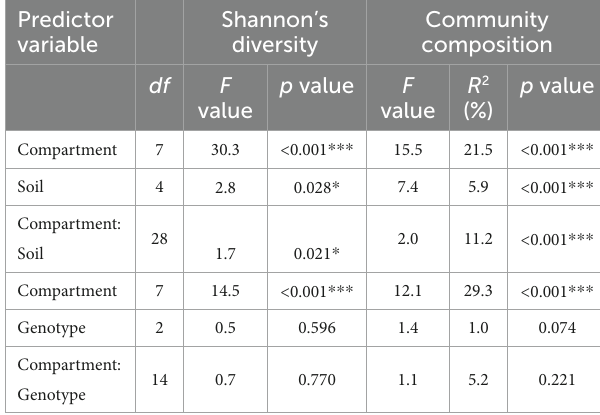
TABLE 1 The impacts of soil, genotype, and plant compartment on the alpha diversity (Shannon’s Diversity Index) and composition (Hellinger transformed OTUs) of fungal communities using ANOVA and PERMANOVA,